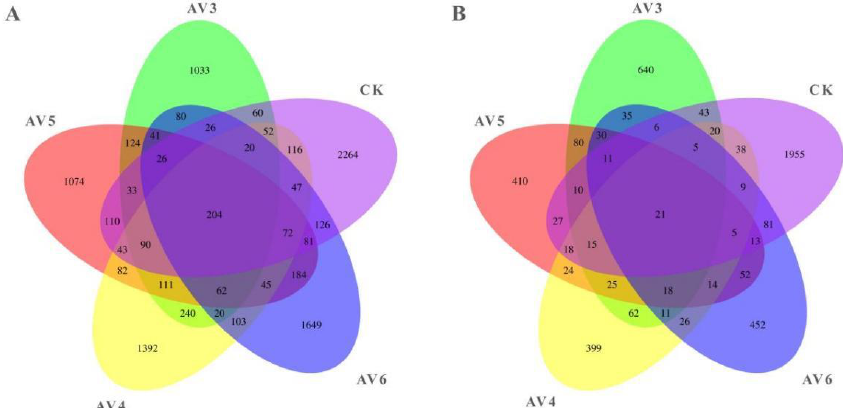
Figure 1. Venn diagram of the bacterial and fungal OTUs for the A. villosum rhizosphere soil samples and the fallow field soil sample. ( A ) Venn diagram of the bacterial OTUs; ( B ) Venn diagram of the fungal OTUs; AV3, AV4, AV5, and AV6 represent the rhizosphere soil samples from the fields in which A. villosum was continuously cropped for 3, 4, 5, and 6 years, respectively, whereas CK rep- resents the soil sample from the fallow field. soil sample from the fallow field.